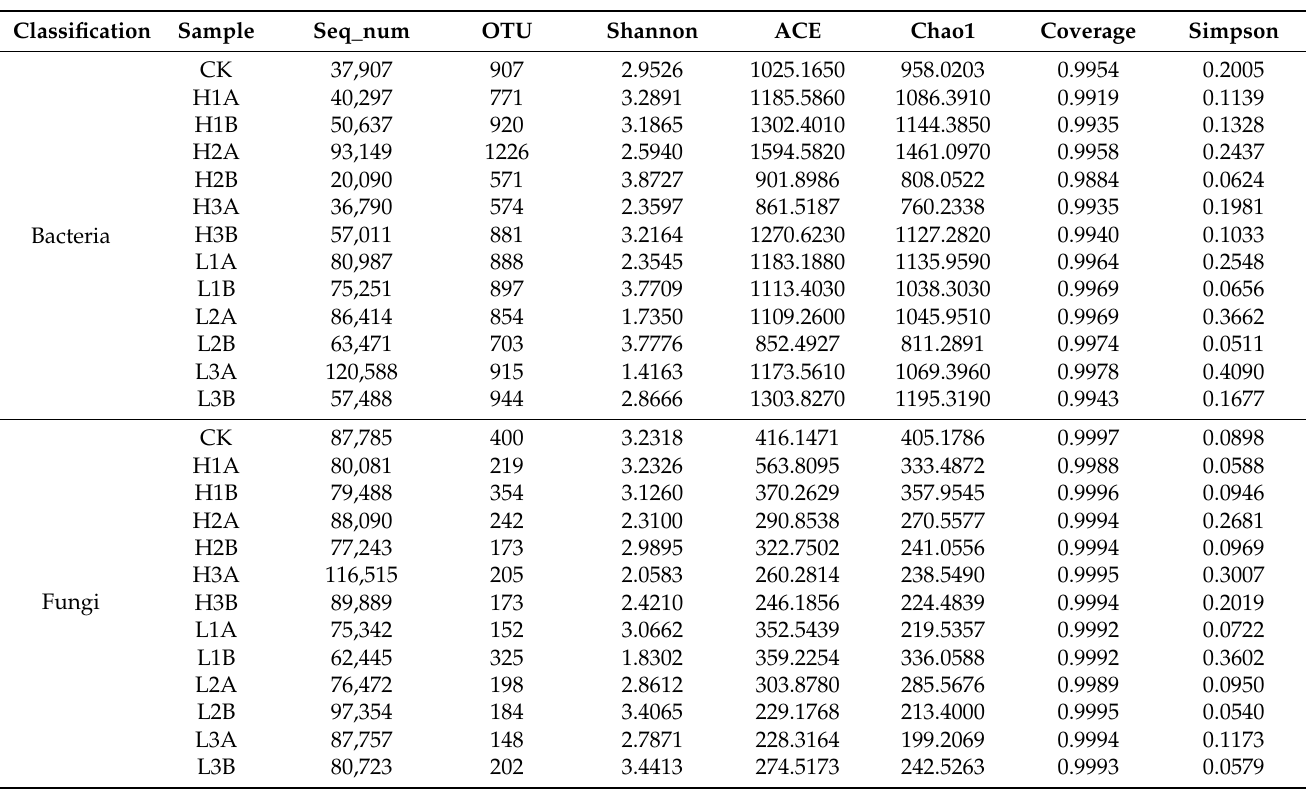
Table 2. Sequence analysis of bacterial and fungal